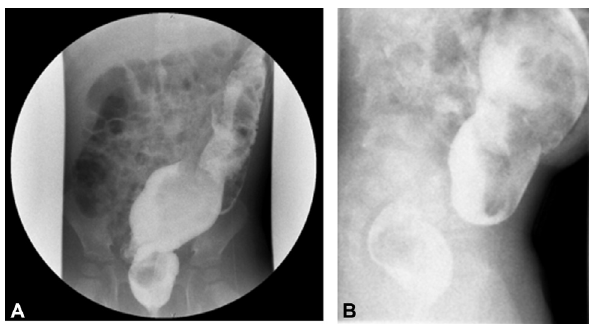
Fig. 2 The ( A ) anteroposterior and ( B ) lateral views of the contrast enema demonstrate reversed rectosigmoid ratio — a dilated sigmoid colon relative to the rectum suggestive of a transition zone.